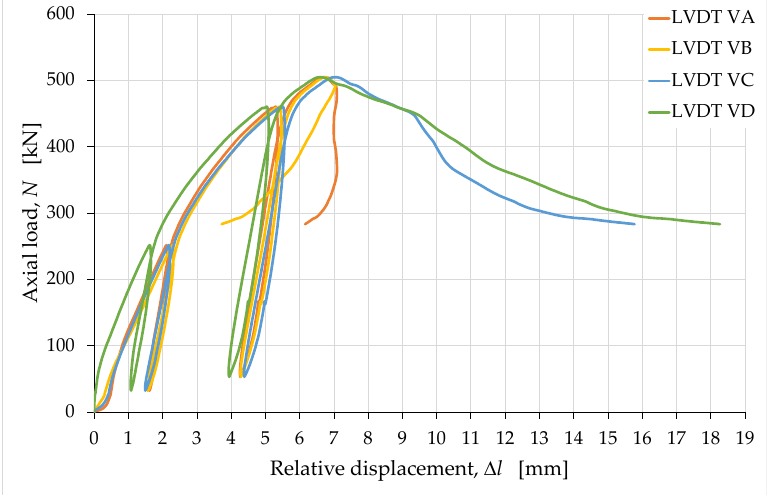
Figure 13. Load/displacement curves acquired between the corners of the metal plates for load distribution.